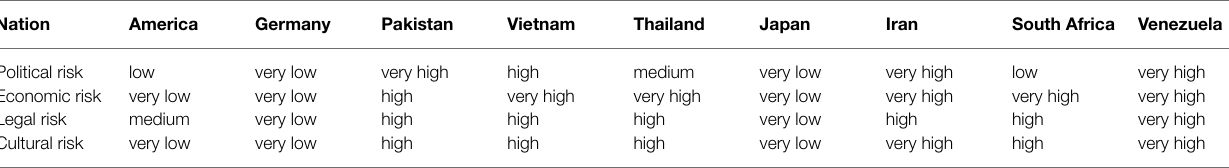
TABLE 12 | Country risk assessment of Haier’s overseas